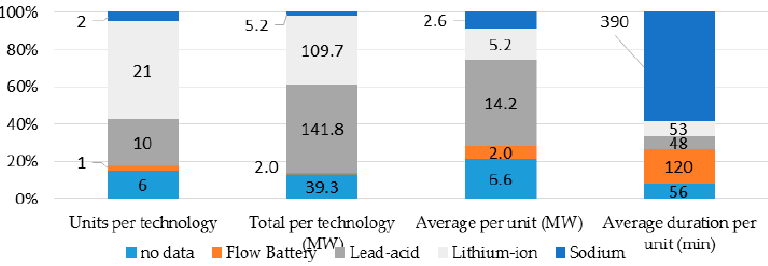
Figure 2. The electrochemical technology of ESS installations, and their relation with power capacity and discharge duration at rated power (same units as in Figure 1).